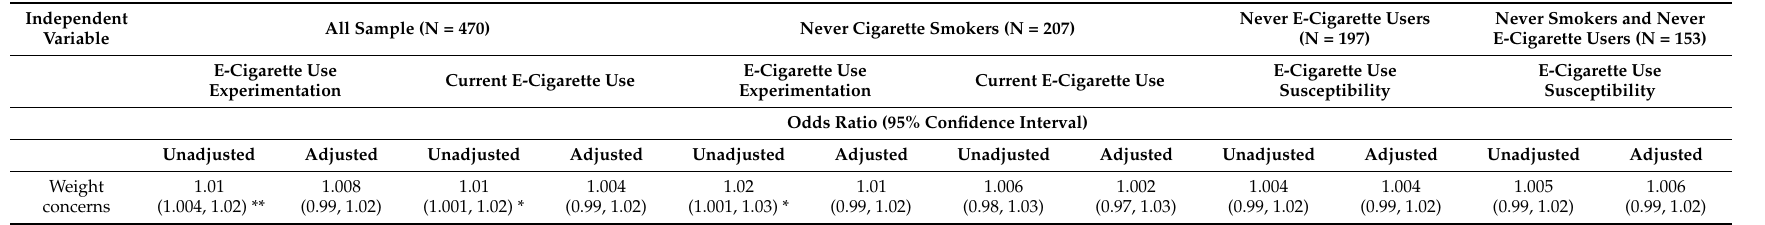
Table 3. Associations of weight concerns with e-cigarette use status and e-cigarette use susceptibility.